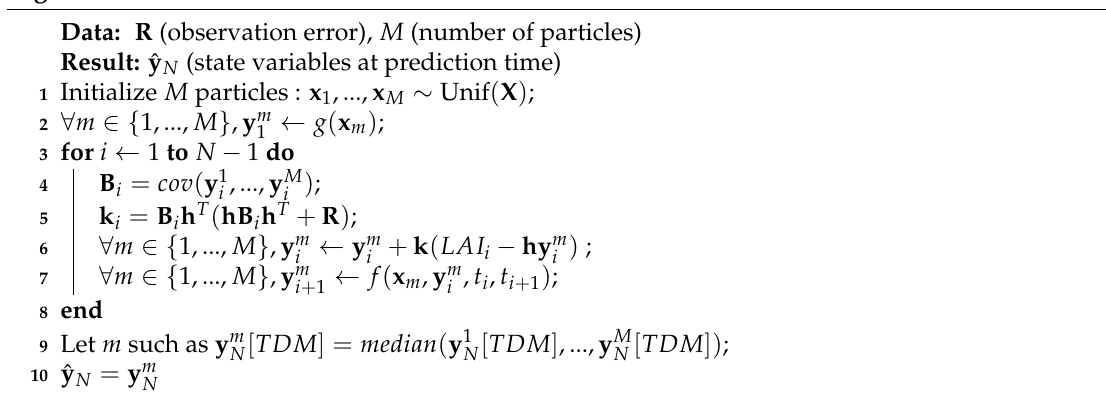
Algorithm A2 EnKF for LAI assimilation Data: R (observation error), M (number of